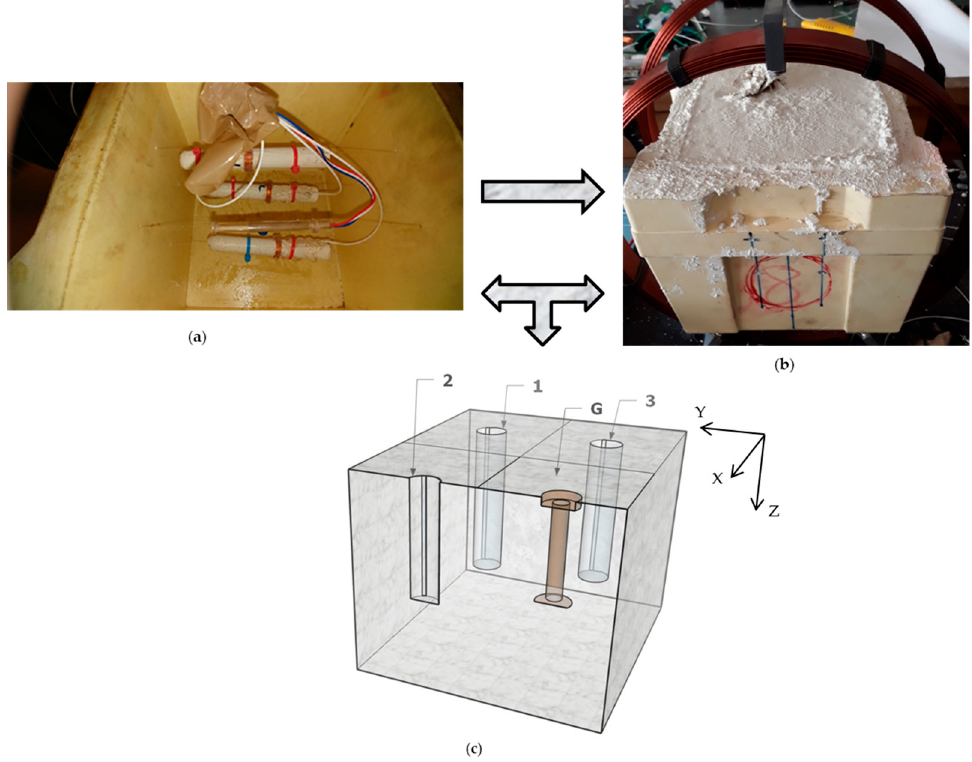
Figure 2. ( a ) MMCC sensors placed in the center of a normalized cubic mold of 150 mm 3 . ( b ) Concrete specimen with embedded sensors. ( c ) Schematic localization of the three sensors labeled 1, 2 and 3 and the strain gauge (G) in the concrete specimen during the stress cycles.